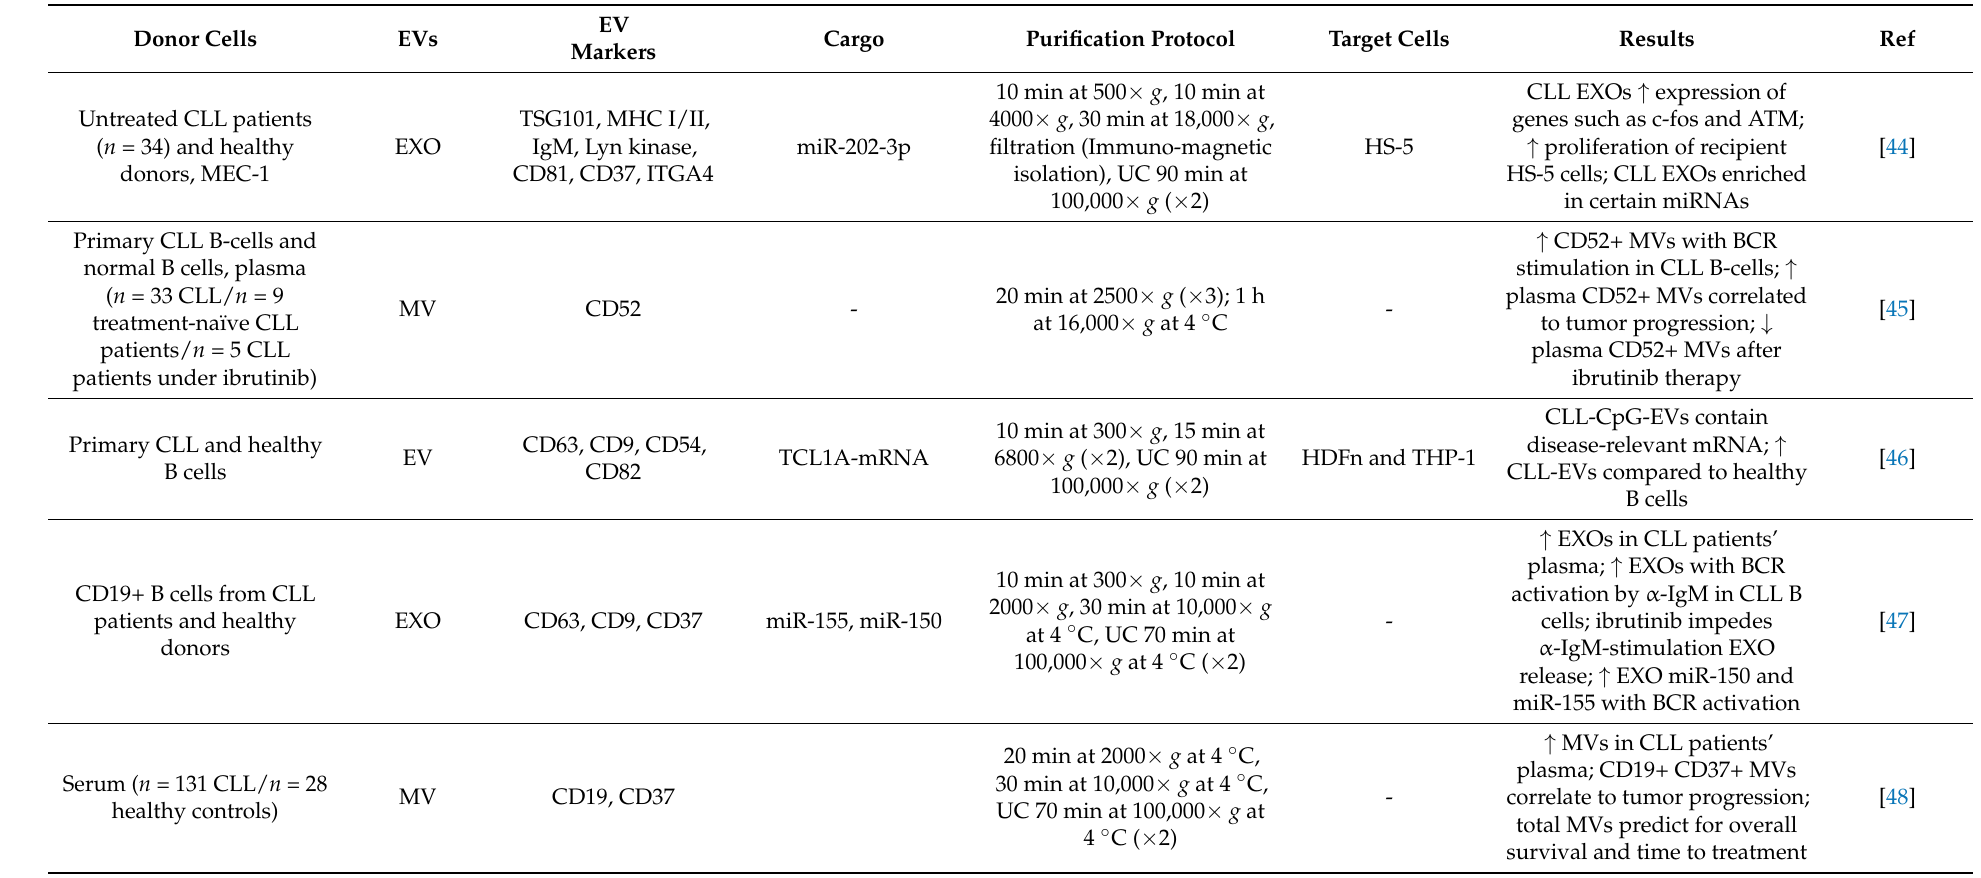
Table 1. Summary of discoveries and protocols used in the main articles about CLL EVs discussed in the review (UC—ultracentrifugation; CLL cell lines: EHEB— HG3—MEC-1—PGA-1; endothelial cell lines: HMEC-1—HUVEC; human BM cell lines: HS5; monocytic cell line: THP-1; primary fibroblasts: HDFn; ↑ : increase; ↓ :